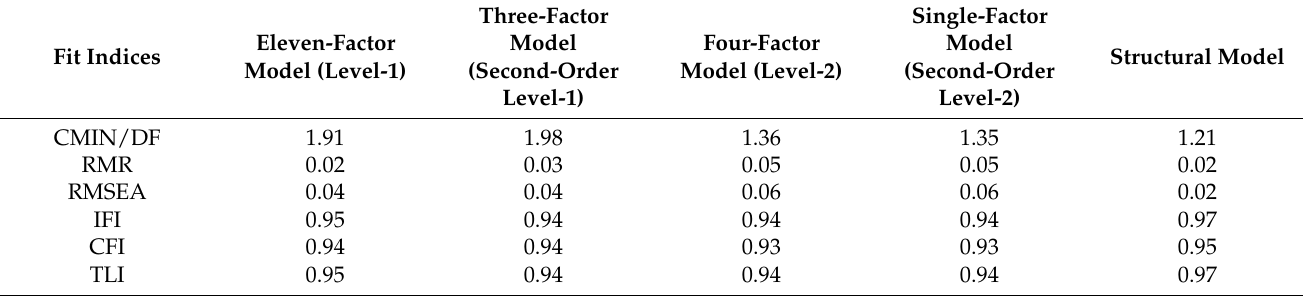
Table 2. Model Fit